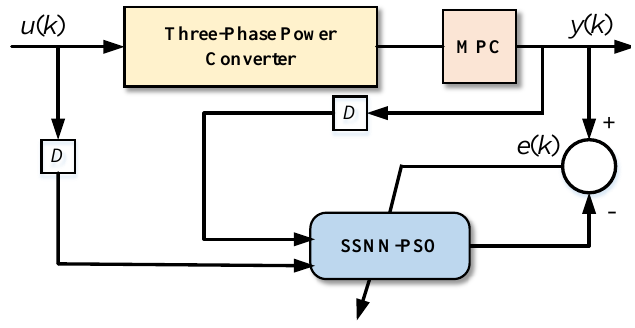
Figure 3. Identification